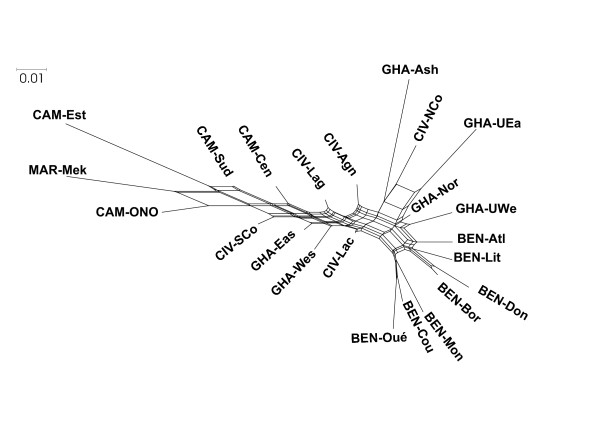
Neighbour-Net for the 23 African local chicken populations, based on Reynolds DR distance.